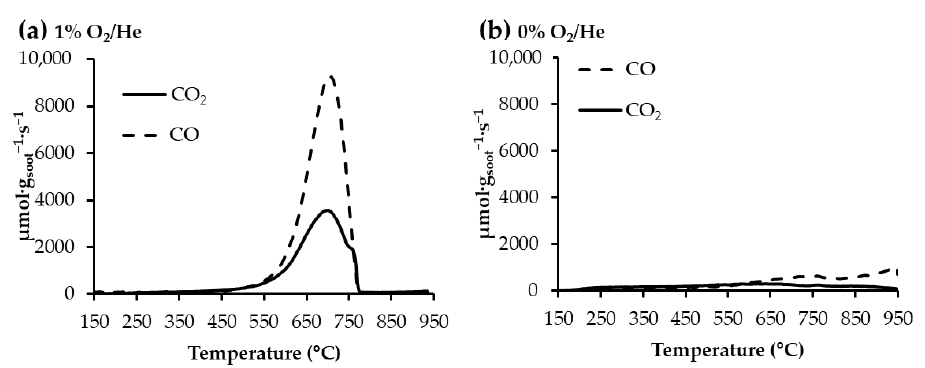
Figure A1. Evolved CO 2 and CO profiles for uncatalyzed soot oxidation: ( a ) in 1% O 2 /He and ( b ) in He.